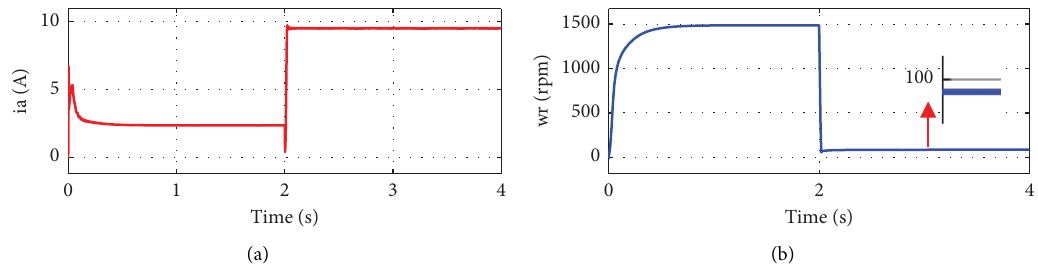
Figure 18: Series DC motor specifcations. (a) Armature Current and (b) speed of DC motor (rpm).